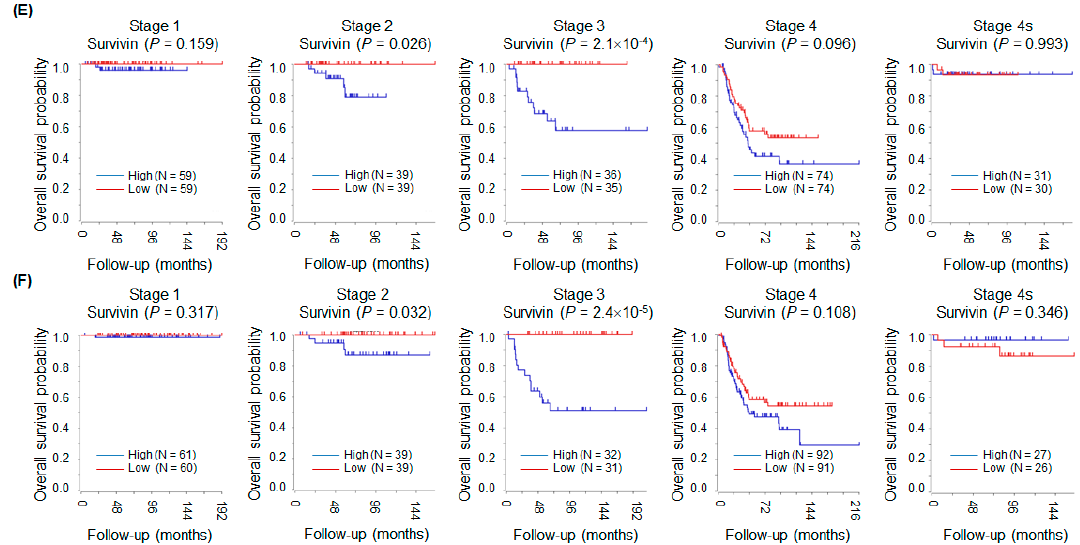
Figure 5. High expression of CCAR2, Hsp60, and survivin is associated with poor survival of neuroblastoma patients. Kaplan–Meier survival analysis was performed using the R2 platform. Expression of CCAR2, Hsp60, and survivin was defined as high (above the median value) or low (below the median value). p -values were calculated using the log-rank test. ( A ) Neuroblastoma patients ( n = 476) from the Kocak dataset. ( B ) Neuroblastoma patients ( n = 498) from the SEQC-RPM dataset. ( C , D ) The Kocak ( C ) and SEQC-RPM ( D ) datasets were sub-grouped into MYCN non-amplified and MYCN amplified subsets. ( E , F ) The Kocak ( E ) and SEQC-RPM ( F ) datasets were sub-grouped according to neuroblastoma stage.